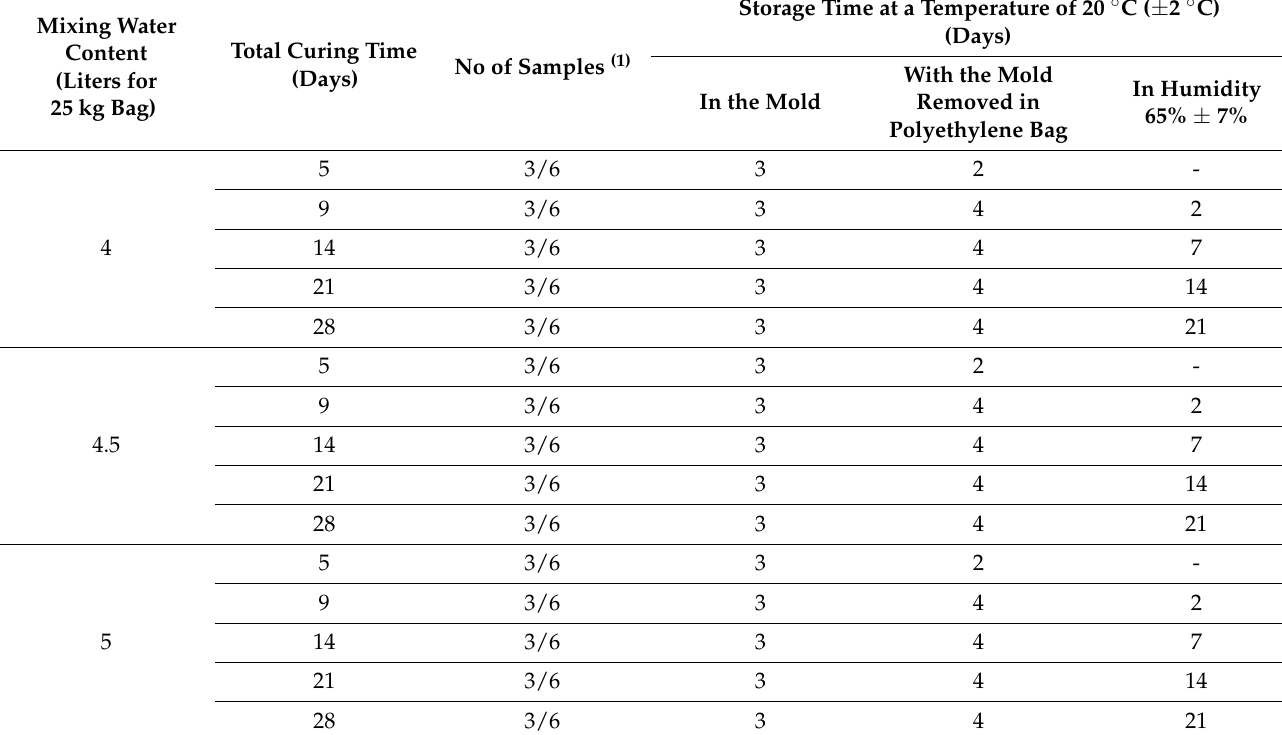
Table 1. Test program—preparation and conditions of storing